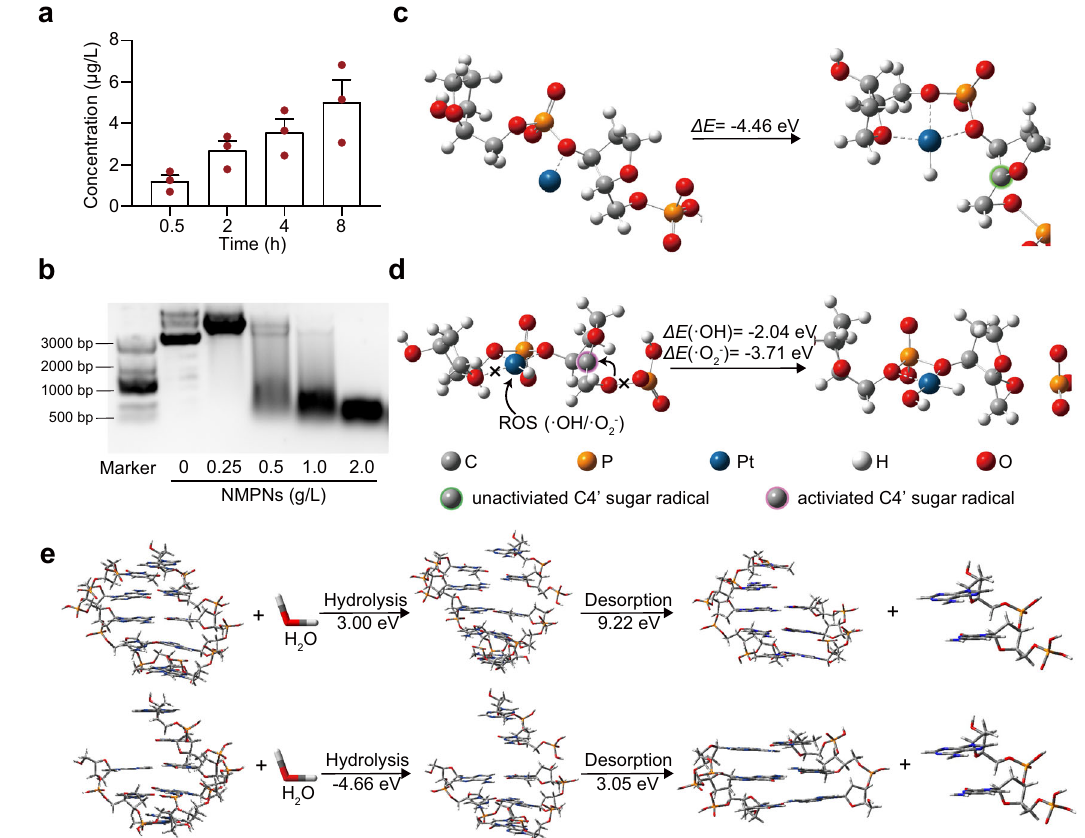
Fig. 4 | NMPNs induce Pt-DNA adducts formation and oxidative cleavage of DNA strand. a The release of Pt ions from NMPNs at different time points under neutral conditions after the discharge of mPEG 5K -AC-CA. b The agarose gel elec- trophoresis of DNA treated with different concentrations of NMPNs. c Schematic illustration of Pt ion binding to DNA backbone. d Schematic illustration of ROS coordinating with Pt ion and causing oxidative DNA cleavage. e Comparison of hydrolysis and desorption process of complete DNA double-stranded fragments